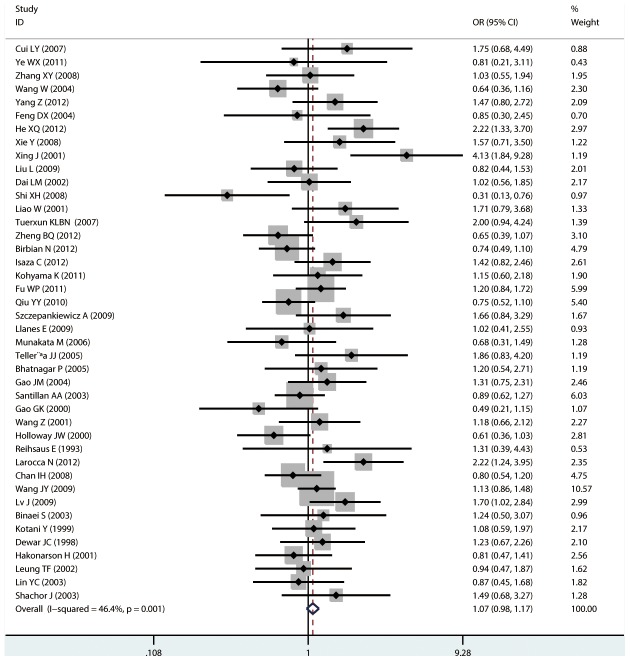
Forest plots of the association between the Arg16Gly (rs1042713) polymorphism and risk of asthma in dominant model comparison.